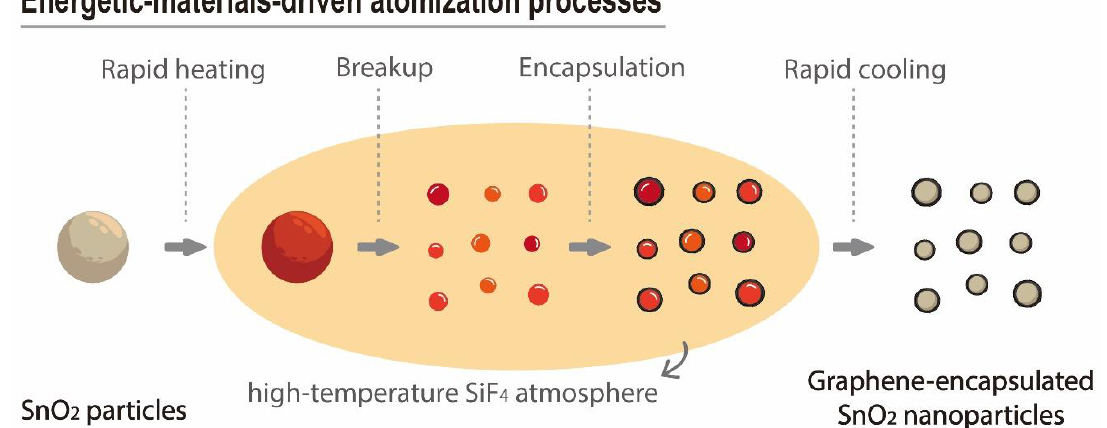
Figure 3. The schematic illustration of energetic-materials-driven atomization and encapsulation processes for the synthesis of graphene-encapsulated SnO 2 nanoparticles.